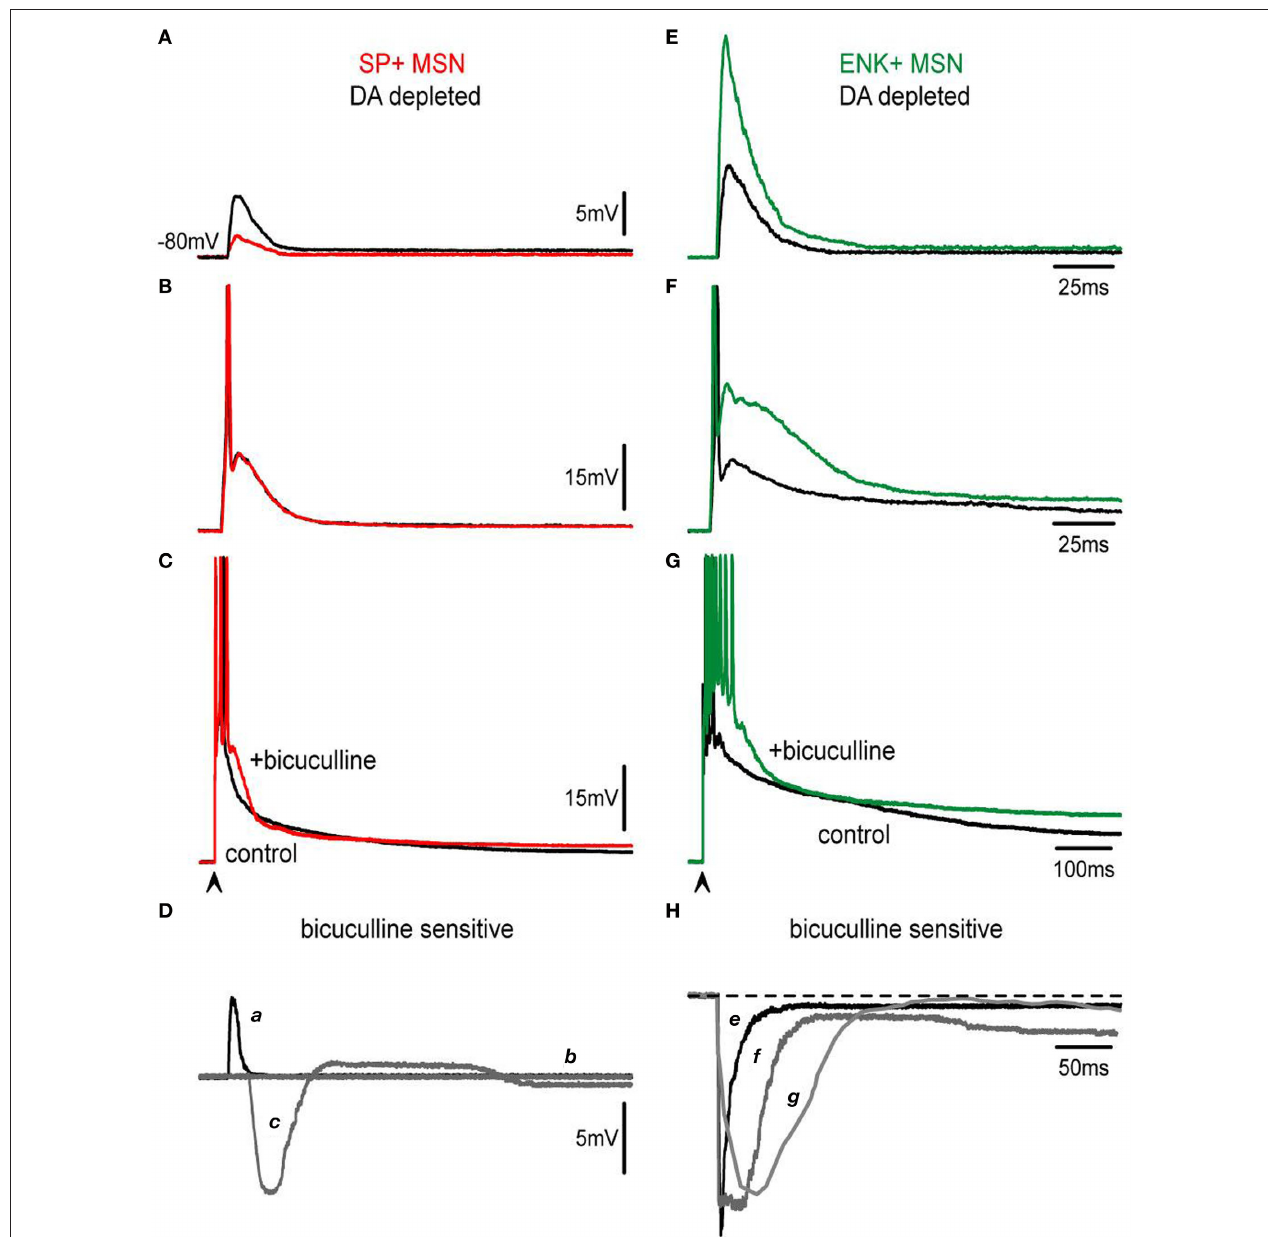
are compared in the same neurons before and during bicuculline (colored traces): a great decrease in bicuculline action is clearly visible in SP + MSNs (cf., Figure 3 ), confirming that recruiting of inhibitory inputs is hindered after attaining certain stimulus strengths. A robust depolarization with a prolonged train of spikes is evident in ENK + MSNs at suprathreshold levels. (D) Digital subtractions of responses in SP + MSNs (a–c) are signaled by corresponding letters. Notice: initial depolarization due to the inhibitory component is much decreased in subthreshold responses (a), while at threshold level bicuculline action seems occluded or not participating (b). Suprathreshold response reveals inhibition of initial depolarization (c) but an almost complete lack of inhibitory participation in the sustaining of the late depolarizing plateau potential. (H) By comparison, bicuculline-sensitive components subtracted from ENK + MSNs responses (e–g) have about the same amplitude for all responses, although more prolonged with increases in stimulus strength, suggesting the activation of intrinsic